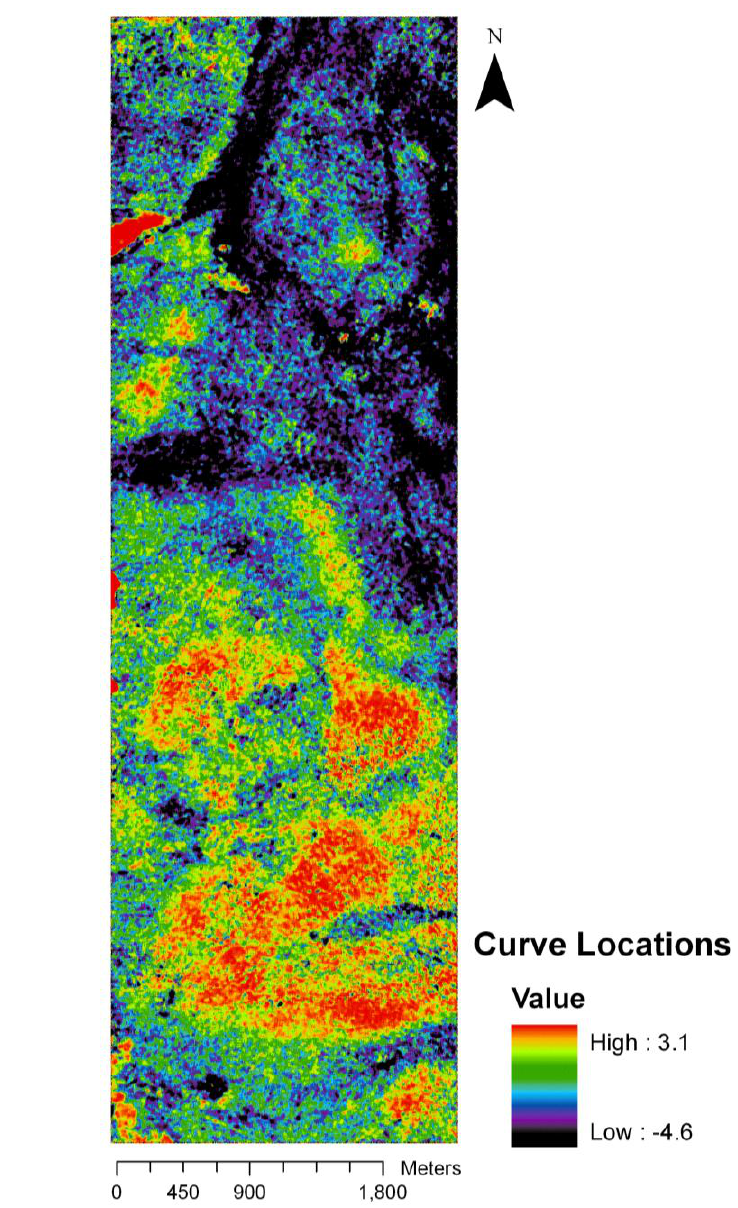
Figure 5. Predicted image of curve locations. Continuous colors from black to red represent the phenological change gradient from left to the right hand side of the